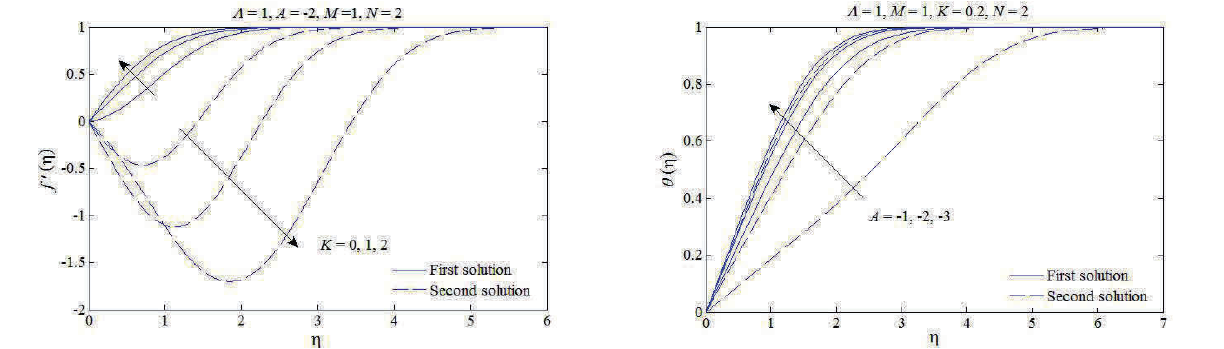
Fig. 8: Velocity profiles for different values of K .